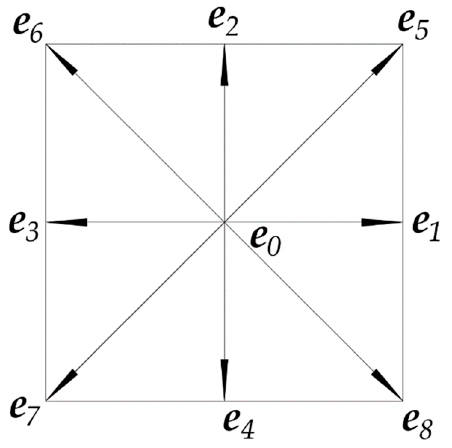
Figure 4. Diagram of D2Q9 Model.